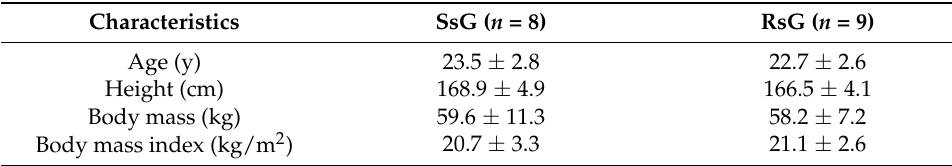
Table 1. Descriptive data of the SsG and RsG.